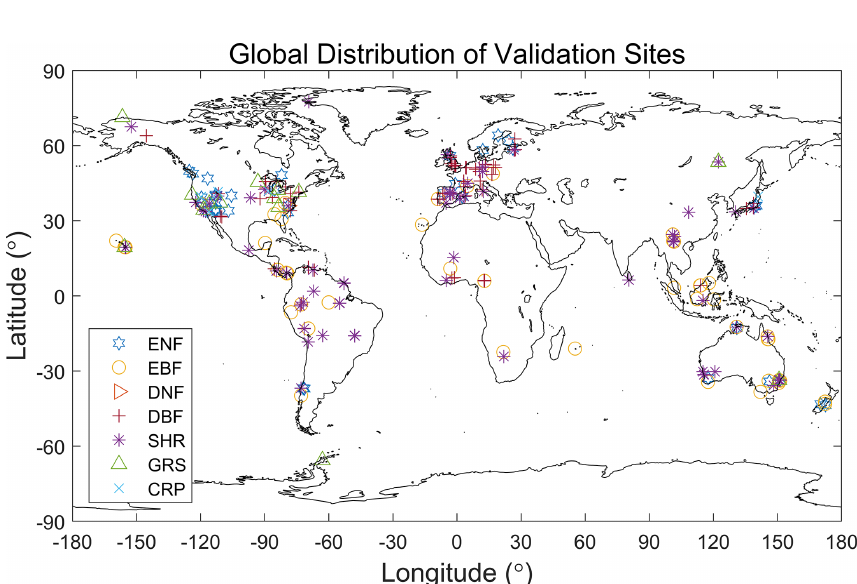
Figure 8. Distribution of ground sites of the database of Smith et al. (2019) after aggregation to 0.5 grids for the different plant functional